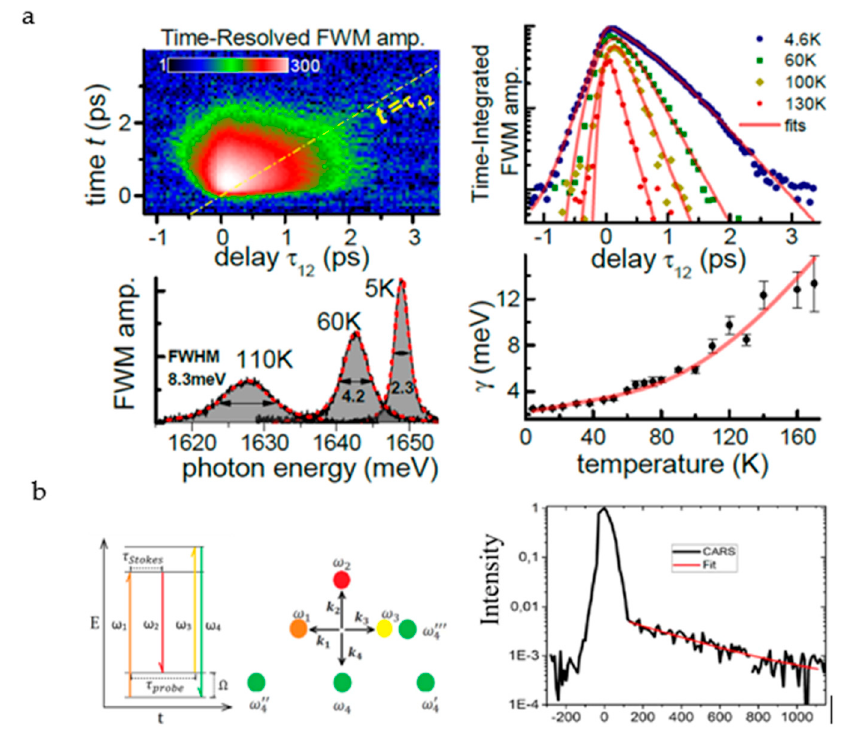
Figure 14. ( a ) The temperature-dependent exciton phase shift which was measured in the MoSe 2 heterostructure region dominated by homogeneous broadening. Reproduced from [103], with permission from American Physical Society, 2020. ( b ) Schematic diagram of time-resolved CARS principle and decay graph of CARS signal with delay time. Reproduced from [108], with permission from American Chemical Society, 2017.